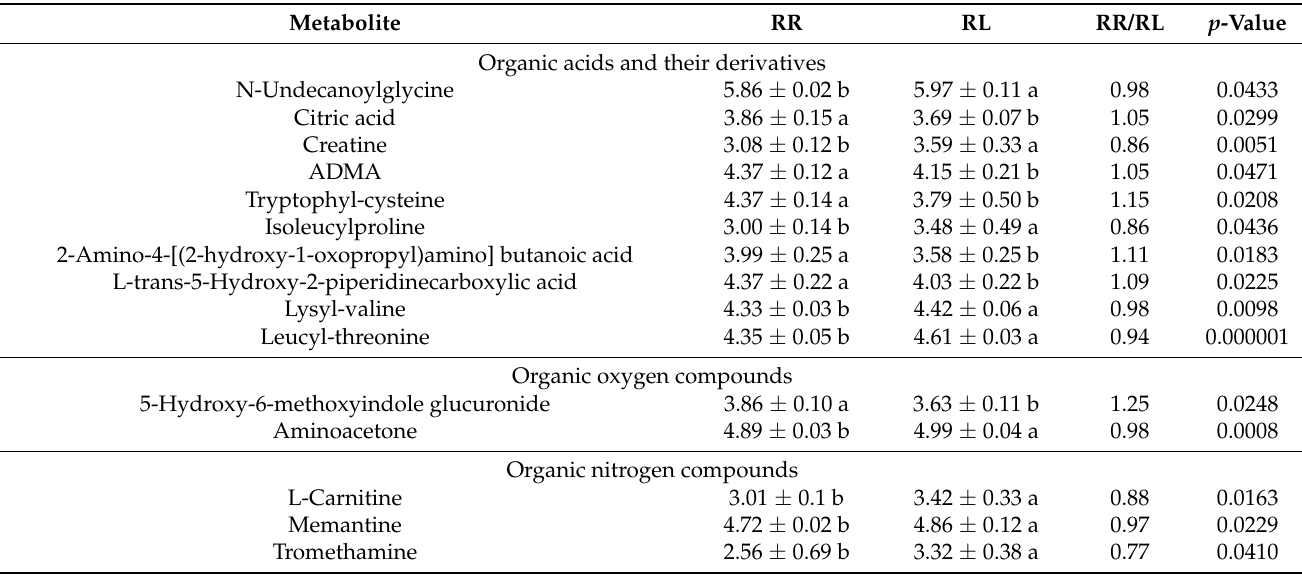
Table 5. The metabolites of differential root exudates in rhizospheres of oilseed rapes between RR and RL systems.